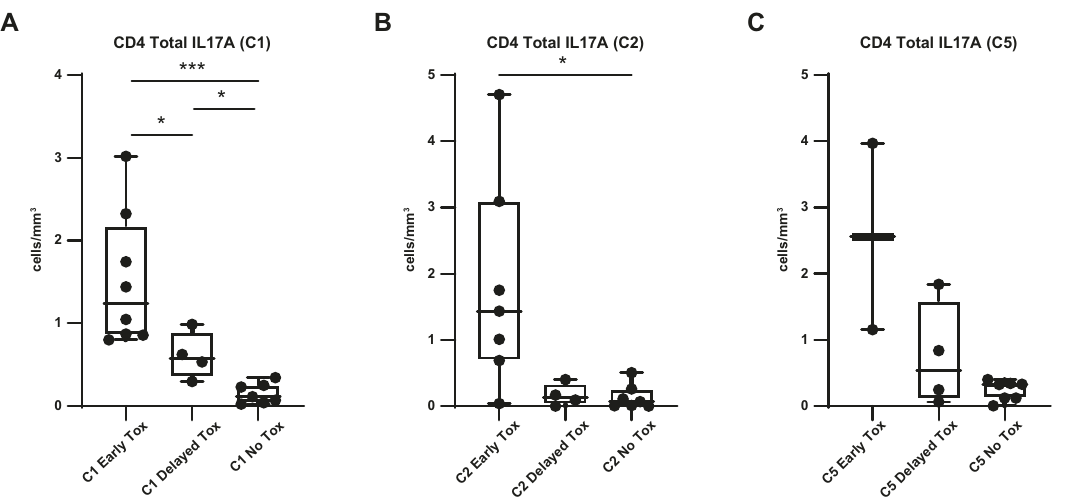
Fig. 3 Absolute number of CD4 + Total IL-17A + cells treated with idelalisib is increased in patients with early Tox compared to Delayed or No Tox. A – C Absolute number of CD4 + Total IL17A + cells, comparing patients with early toxicity to delayed toxicity to no toxicity. A At C1 prior to therapy. B At C2. C At C5. * p ≤ 0.05; *** p ≤